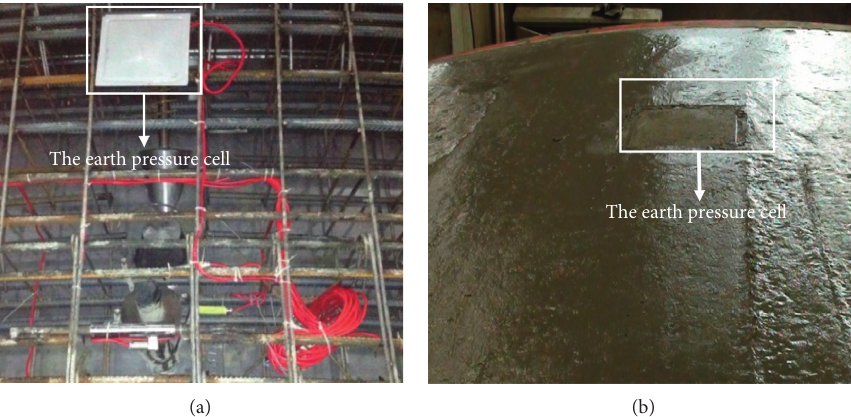
Figure 5: Photos of the earth pressure cell: (a) before segment lining concrete casting and (b) after segment lining concrete